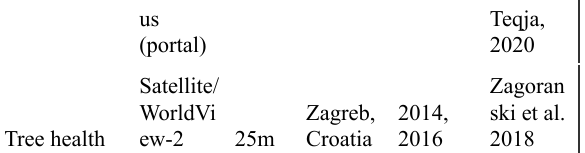
Table 3 . Remote sensing data applied in the most relevant studies of forest cover change, forest health and tree health using Scopus. No relevant forest cover change studies were found for Slovenia and Montenegro.